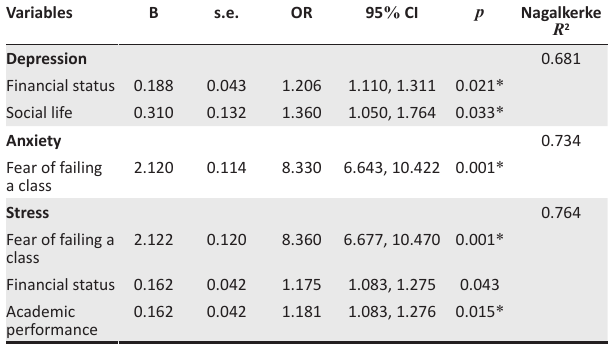
FIGURE 1: A cascade effect among the psychological symptoms and the predictor variables. TABLE 6: Influence of the predictor variables on the psychological